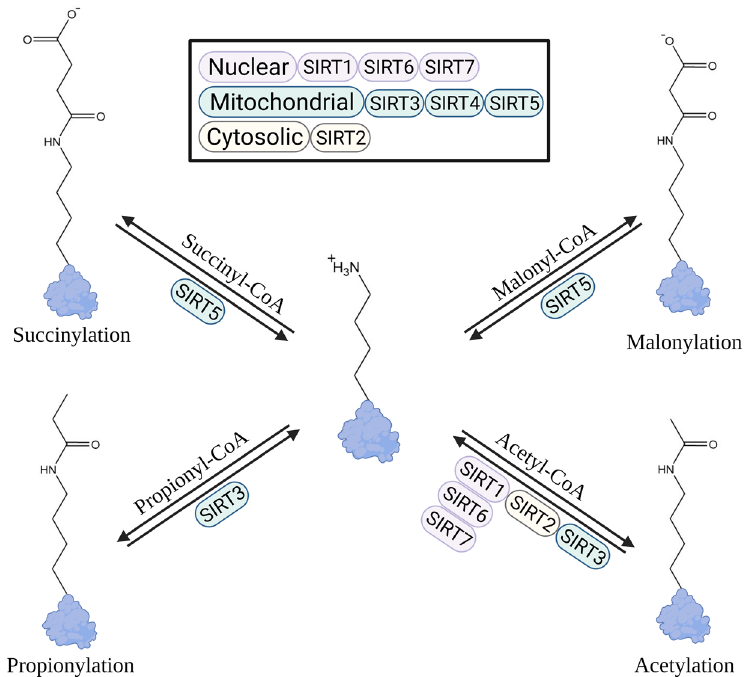
Figure 1. Acyl-CoA species generated during central metabolism modify protein Lys residues.